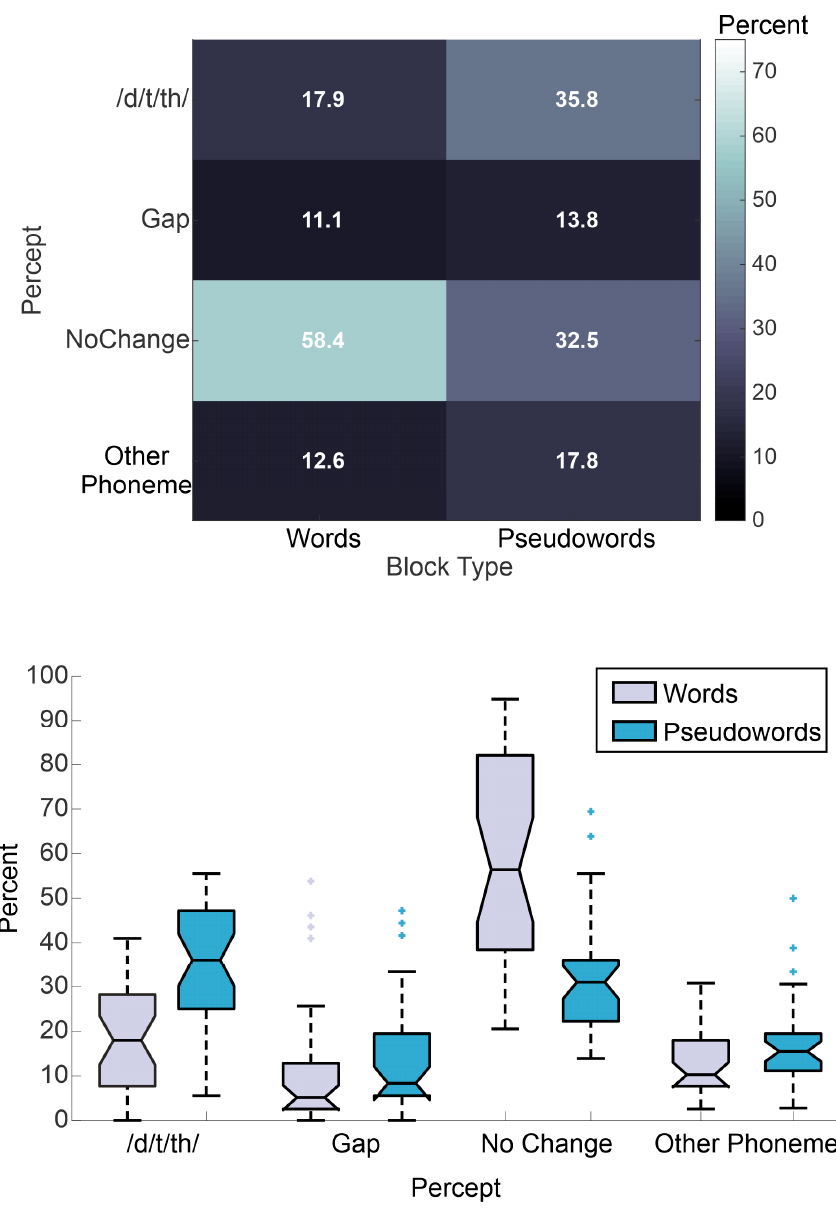
Figure 1. Results of the Auditory-Only Filling-in Task. Top portion shows the group average percentages of each percept, separately for the Word and Pseudoword stimuli. Bottom portion shows box plots of the same data.